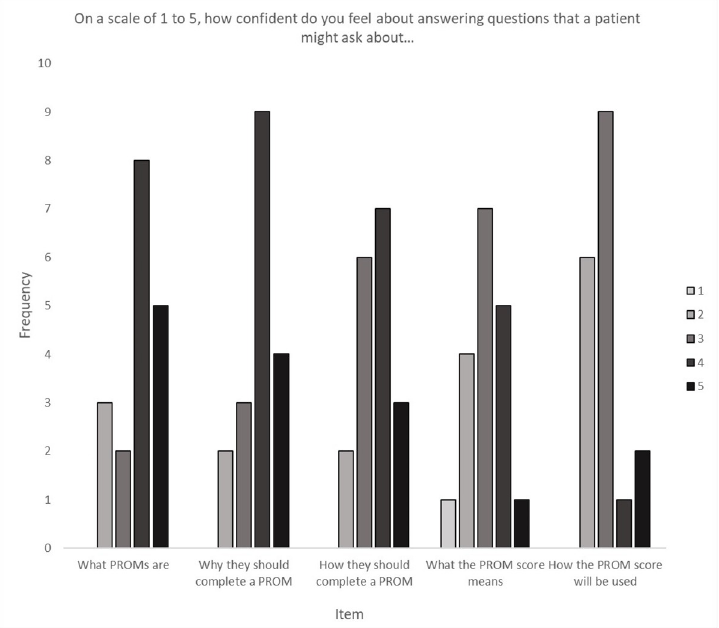
Fig 1. Clinicians’ self-reported confidence to answer hypothetical questions a patient might ask about